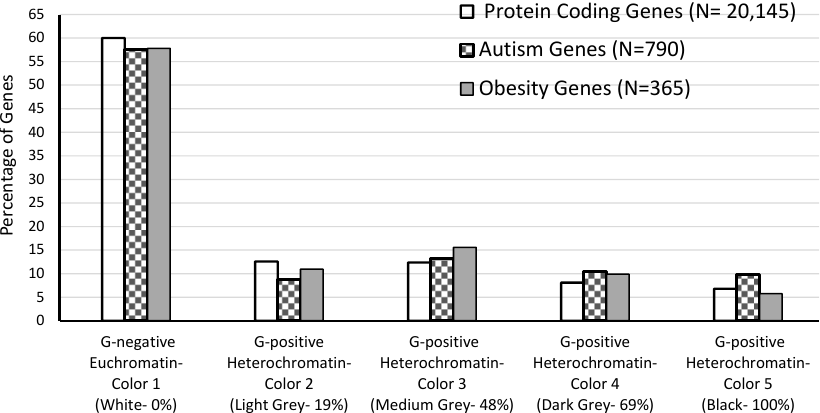
Figure 4. Genome-wide distribution of protein-coding, autism and obesity genes by Giemsa band intensity rating. Calculations excluded genes located in the qh, centromeric and acrocentric chromosome p arm regions. Table 3. Summary data of chromosome bands and genes by group for each chromatin type.